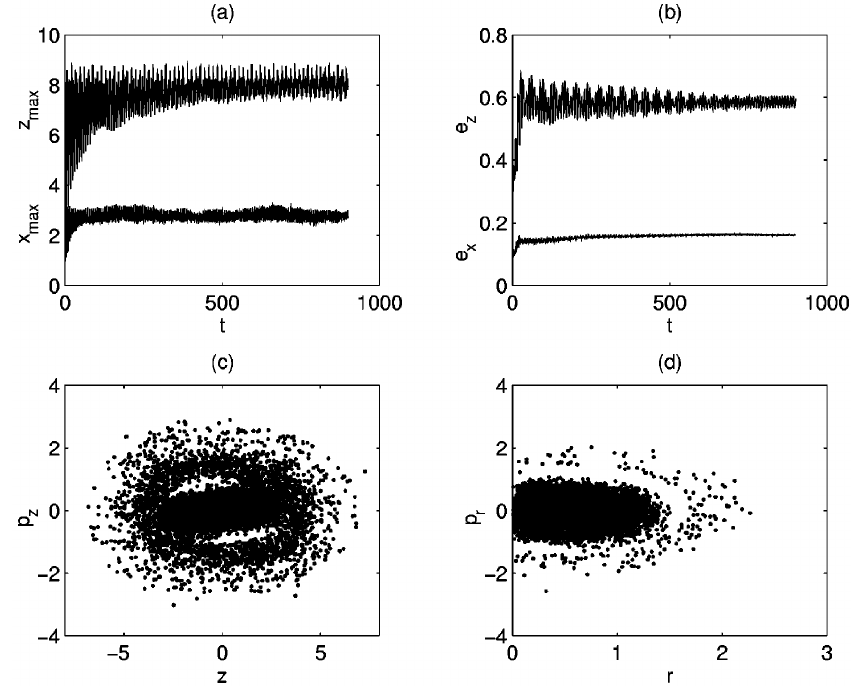
FIG. 11. 6D Gaussian distribution m (cid:120) (cid:173) m (cid:121) (cid:173) m (cid:122) (cid:173) (cid:49)(cid:46)(cid:53) ( (cid:99) (cid:121) (cid:97) (cid:173) (cid:51)(cid:44) h (cid:120) (cid:173) (cid:48)(cid:46)(cid:53)(cid:51)(cid:44) h (cid:122) (cid:173) (cid:48)(cid:46)(cid:51)(cid:57) ): (a) maximum (cid:120) and (cid:122) , (b) emittance growth, (c) (cid:122) (cid:45) (cid:112) (cid:122) diagram at (cid:116) (cid:173) (cid:57)(cid:48)(cid:48) (with 32 768 particles plotted), and ( d) (cid:114) (cid:45) (cid:112) (cid:114) diagram at (cid:116) (cid:173) (cid:57)(cid:48)(cid:48) for particles with the angular momentum j (cid:76) (cid:122) j , (cid:48)(cid:46)(cid:49) (with 25 000 particles